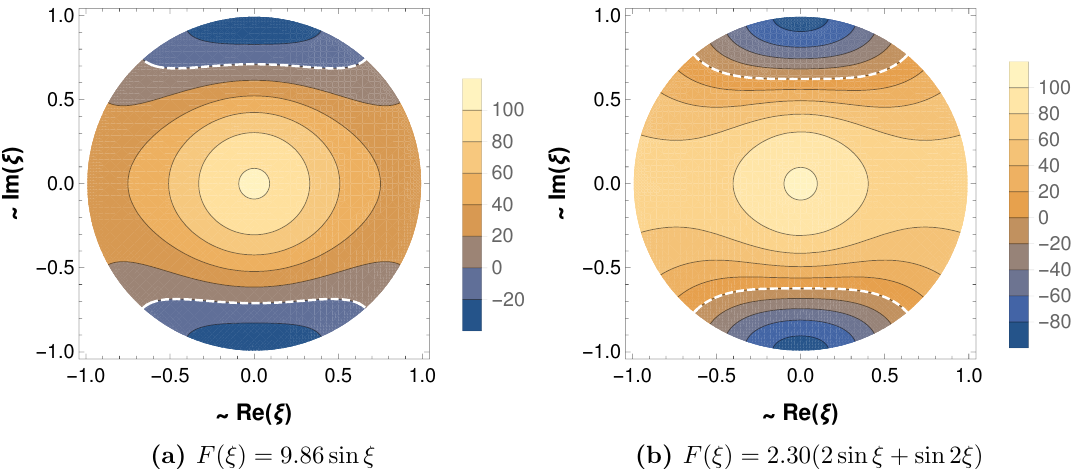
Figure 2. Contour plots of ~ g yy with ( a = 1 ; R y = 1 ; (cid:18) = 0 ; c = 100) for speci(cid:12)ed F ( (cid:24) ). Plotted on the unit disc j (cid:24) j (cid:20) 1 with radial direction rescaled to tan r . The boundaries between positive and negative domains (~ g yy = 0) are separated by a dashed white